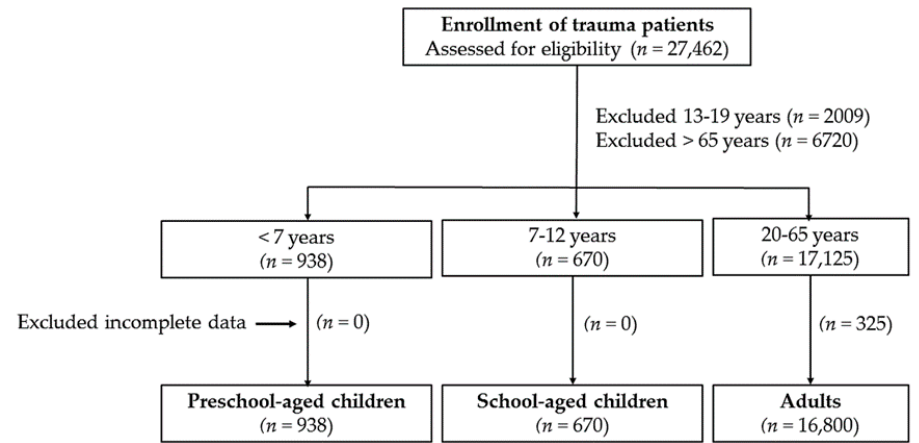
Figure 1. Flow chart of the distribution of the studied population into preschool-aged children, school-aged children, and adults.